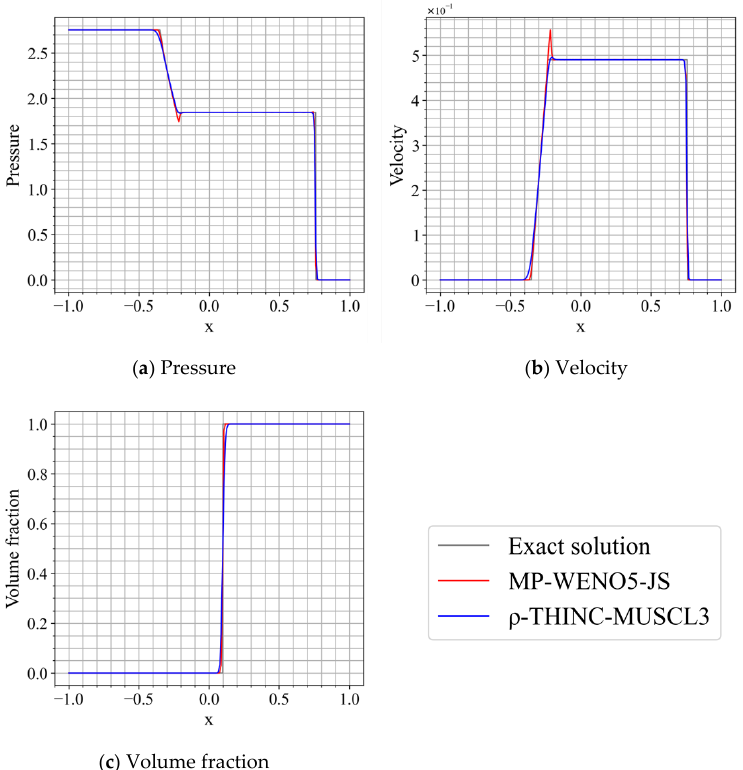
Figure A1. Result of Gas – liquid Riemann problem. The exact and numerical solutions are compared at 𝑡 = 0.2 .